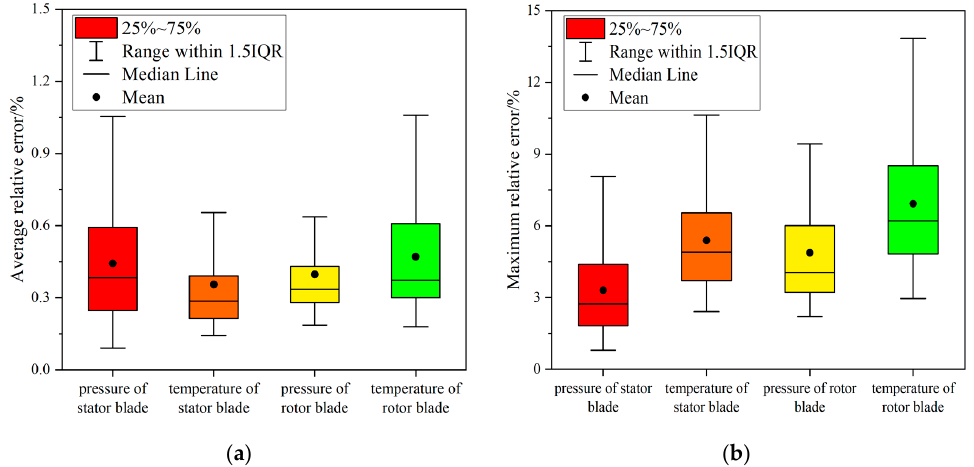
Figure 10. The relative error: ( a ) the average relative error; ( b ) the maximum relative error. The prediction results, 3-D CFD results and error distributions of Cases A and B are shown in